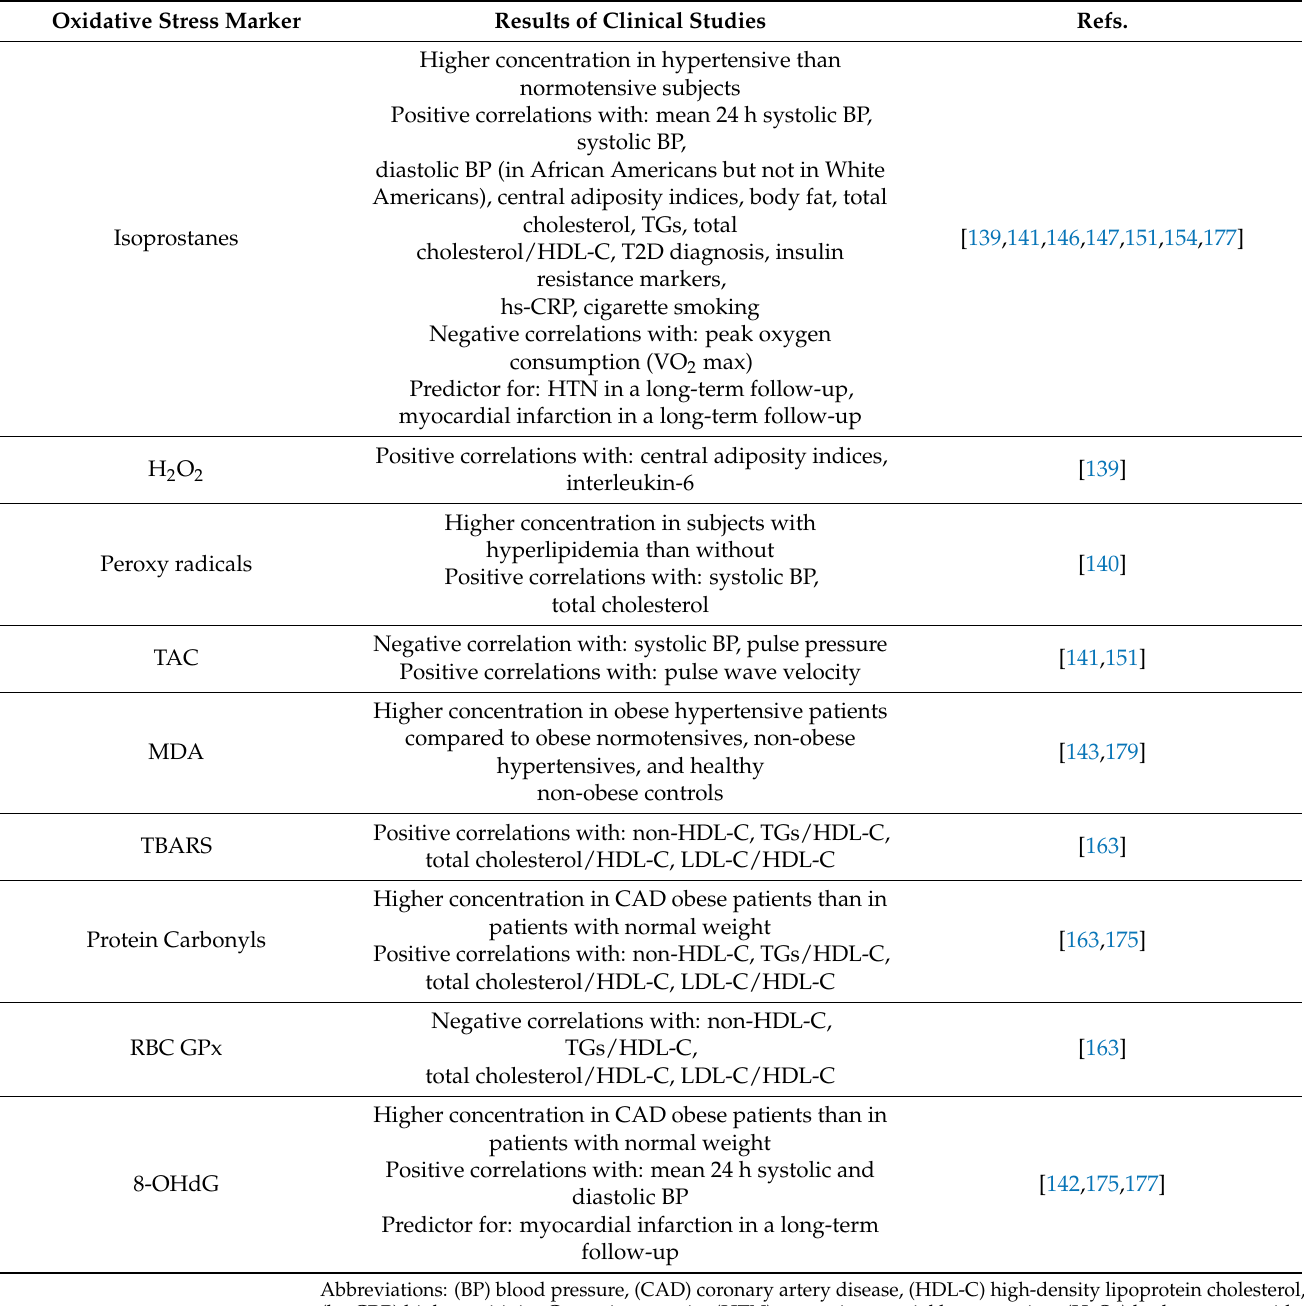
Table 2. Relationships between selected oxidative stress markers and cardiometabolic parameters in obese subjects with cardiometabolic